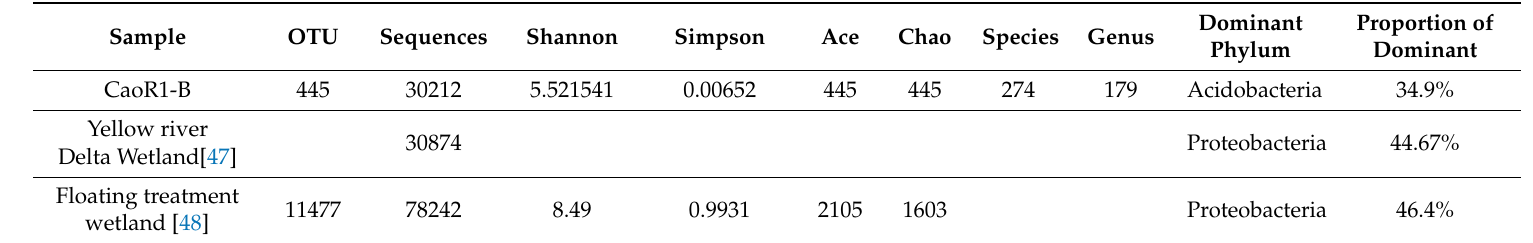
Table 3. Dominant phylum, high quality sequences, richness and diversity estimators of the rhizosphere sample (CaoR1-B), and comparison with other wetland